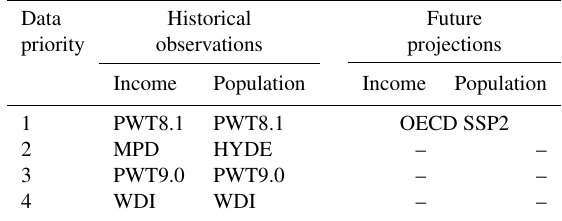
Table 1. Overview of data sources used to create the final data prod- uct ranked according to their priority. Please refer to Sects. 2.1 and 2.2 for details on the data